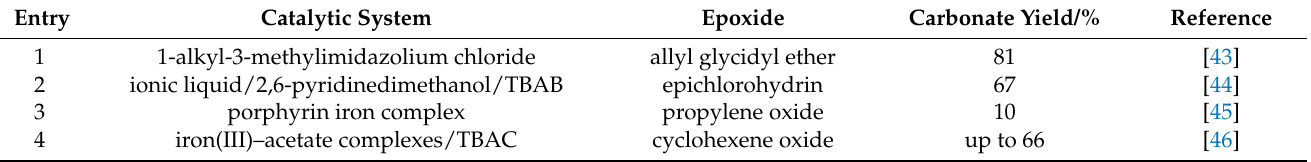
Table 4. Cycloaddition of CO 2 to epoxides catalyzed by different classes and types of homogeneous catalysts.